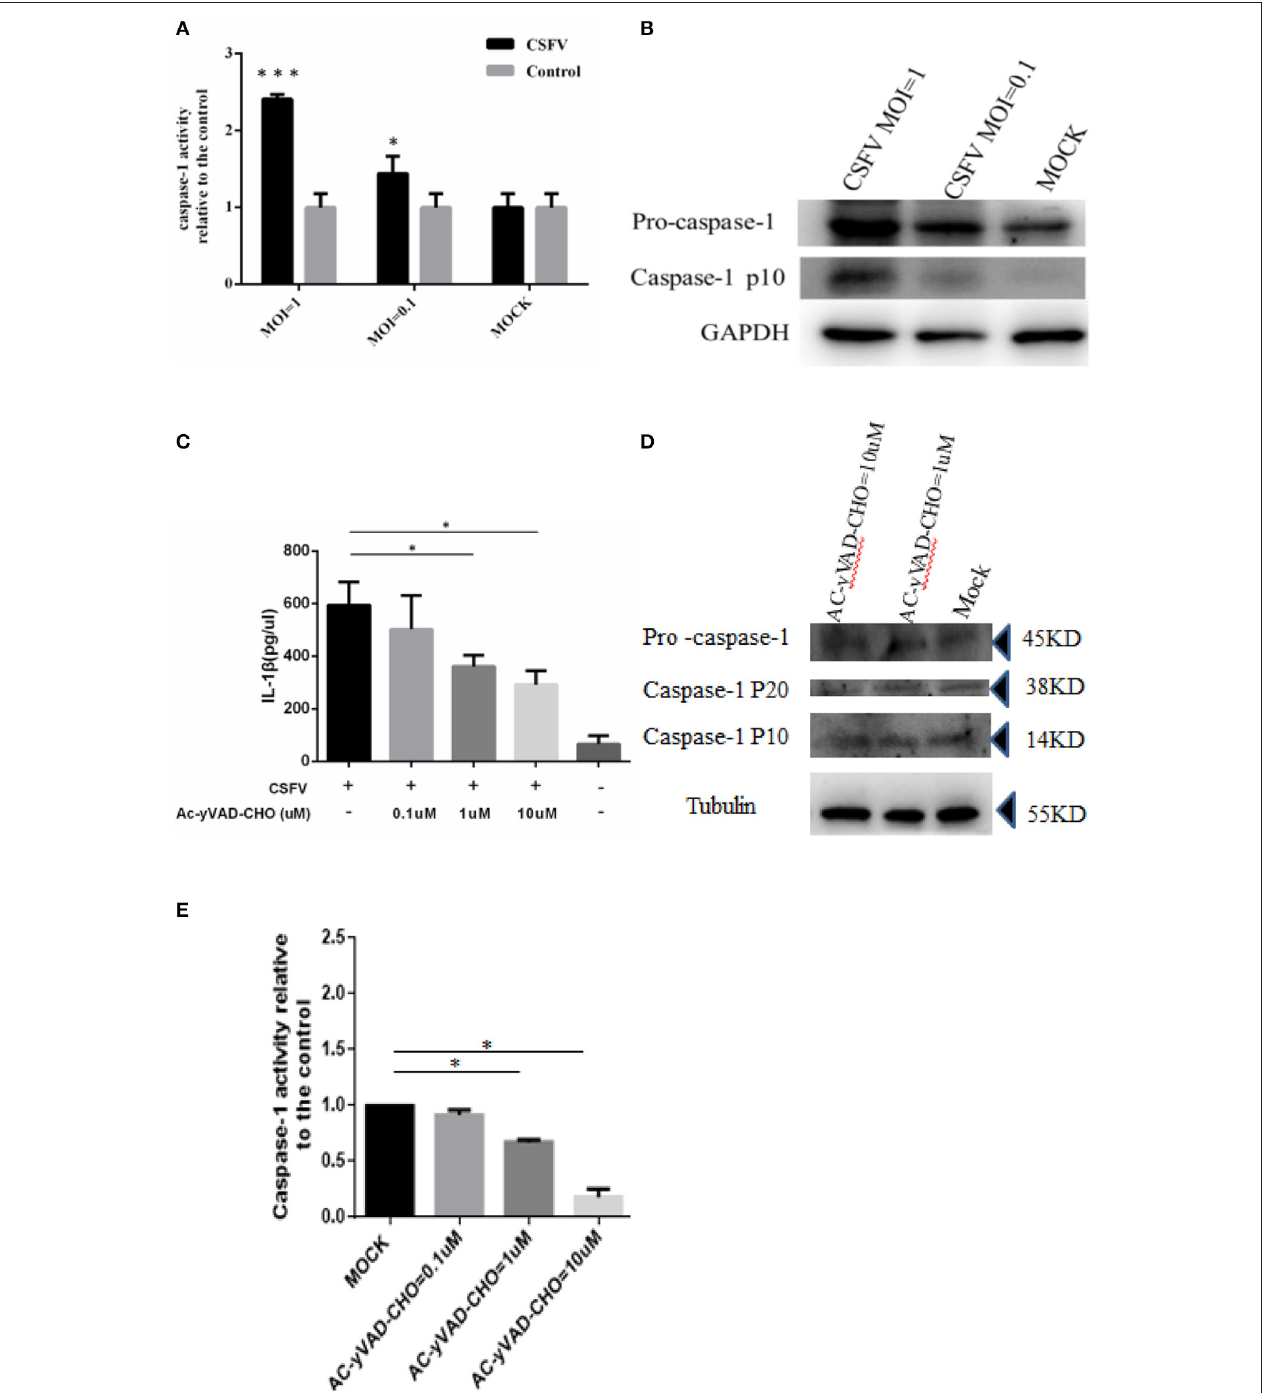
FIGURE 2 | Activation of IL-1 β induced by CSFV infection was dependent on caspase 1. (A) The caspase 1 was activated by CSFV infection. PBMCs were mock treated or infected with CSFV at a MOI of 1 or 0.1 for 6h. (B) The expression of pro-caspase 1 and the cleavage of caspase-1p10 protein were identified by western blot analysis following CSFV infection (MOI of 1 or 0.1). (C) Following treatment with the caspase 1 inhibitor Ac-yVAD-CHO, the activation of IL-1 β induced by CSFV was inhibited. (D) The expression of caspase 1 precursor and the subunit p20/P10 proteins were not affected by treatment with AC-yVAD-CHO. (E) Caspase 1 activity was dose-dependently inhibited by AC-yVAD-CHO, and CSFV activated caspase 1 activity at an MOI of 1. * P < 0.05; *** P < 0.001. P -values were calculated using an One-way ANOVA test.